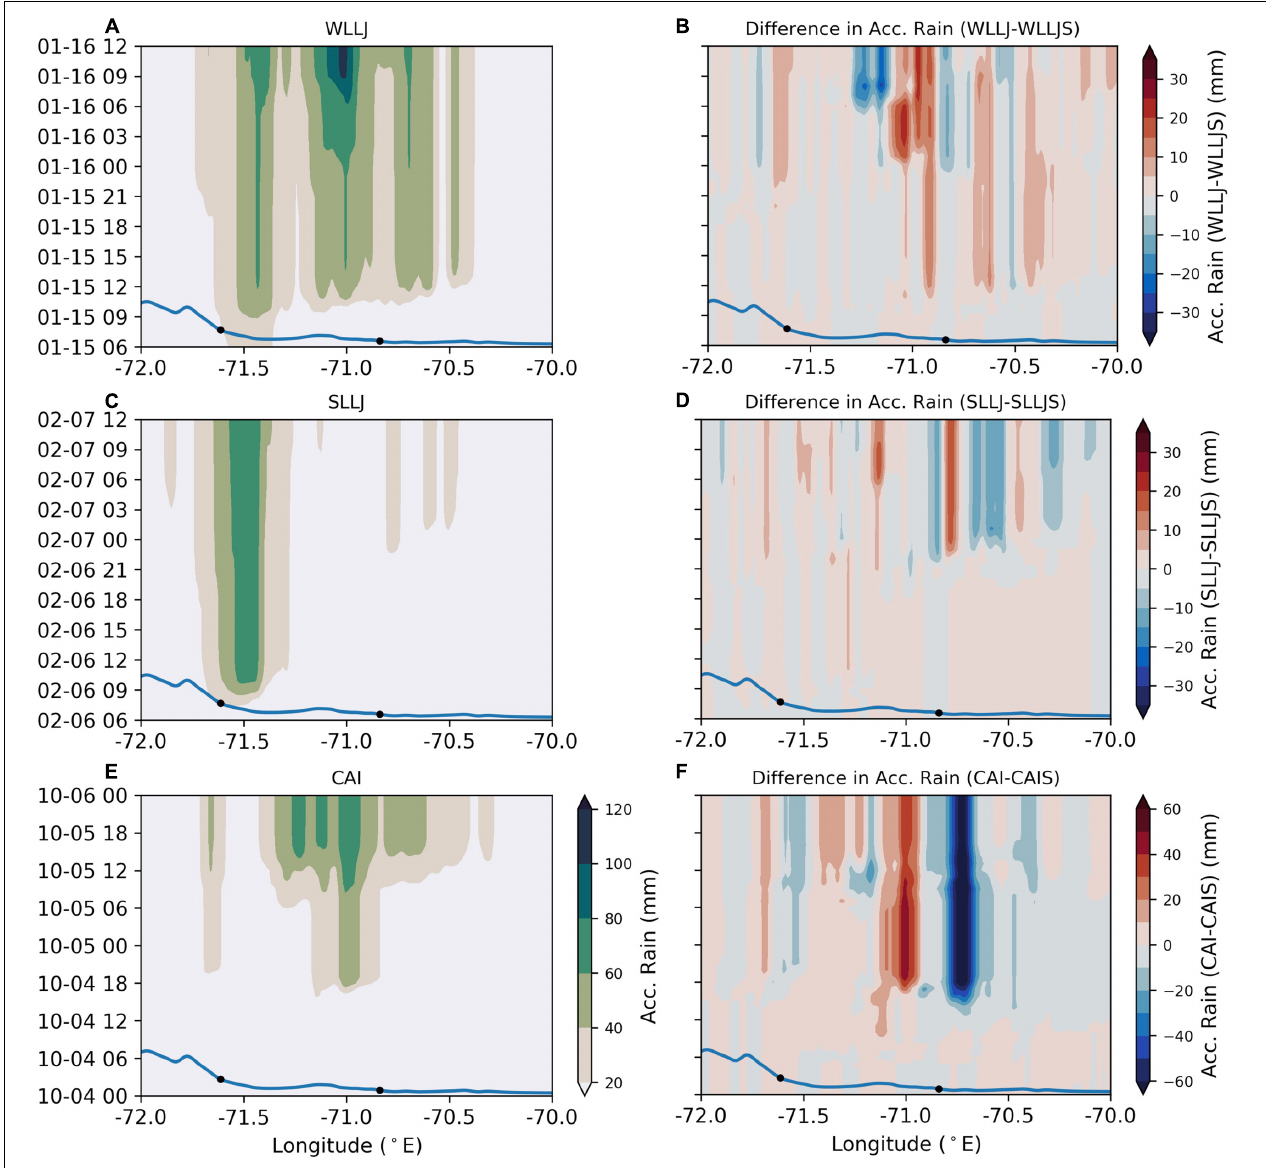
FIGURE 7 | Hövmöller diagram of the evolution of accumulative rain for TMF runs (left column) and the accumulative rain differences TMF-savanna (right column), respectively, for WLLJ and WLLJS (A,B) , SLLJ and SLLJS (C,D) , and CAI and CAIS (E,F) cases. The rain is accumulated from the beginning of each simulation. The values are from the WRF high-resolution domain (D03, 1.2 km) averaged over a 30 km wide cross-section band centered at latitude 13.00 S. The blue line shows the topographic profile at 13.00 S. The circles mark the 500 and 1,500 m